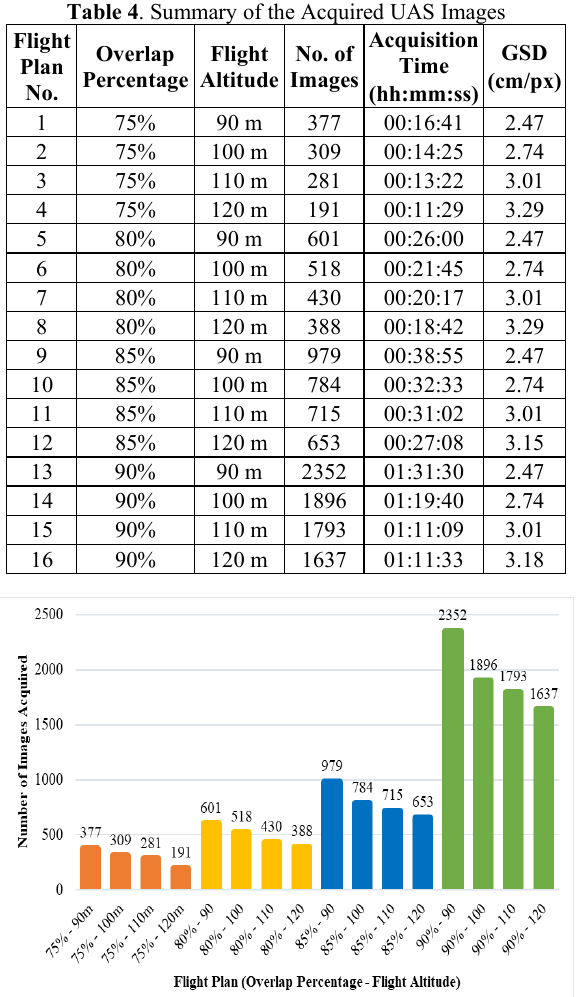
Figure 3 . Bar Graph for the visualization of flight plans based on a number of images acquired with respect to overlap percentage and flight altitude.